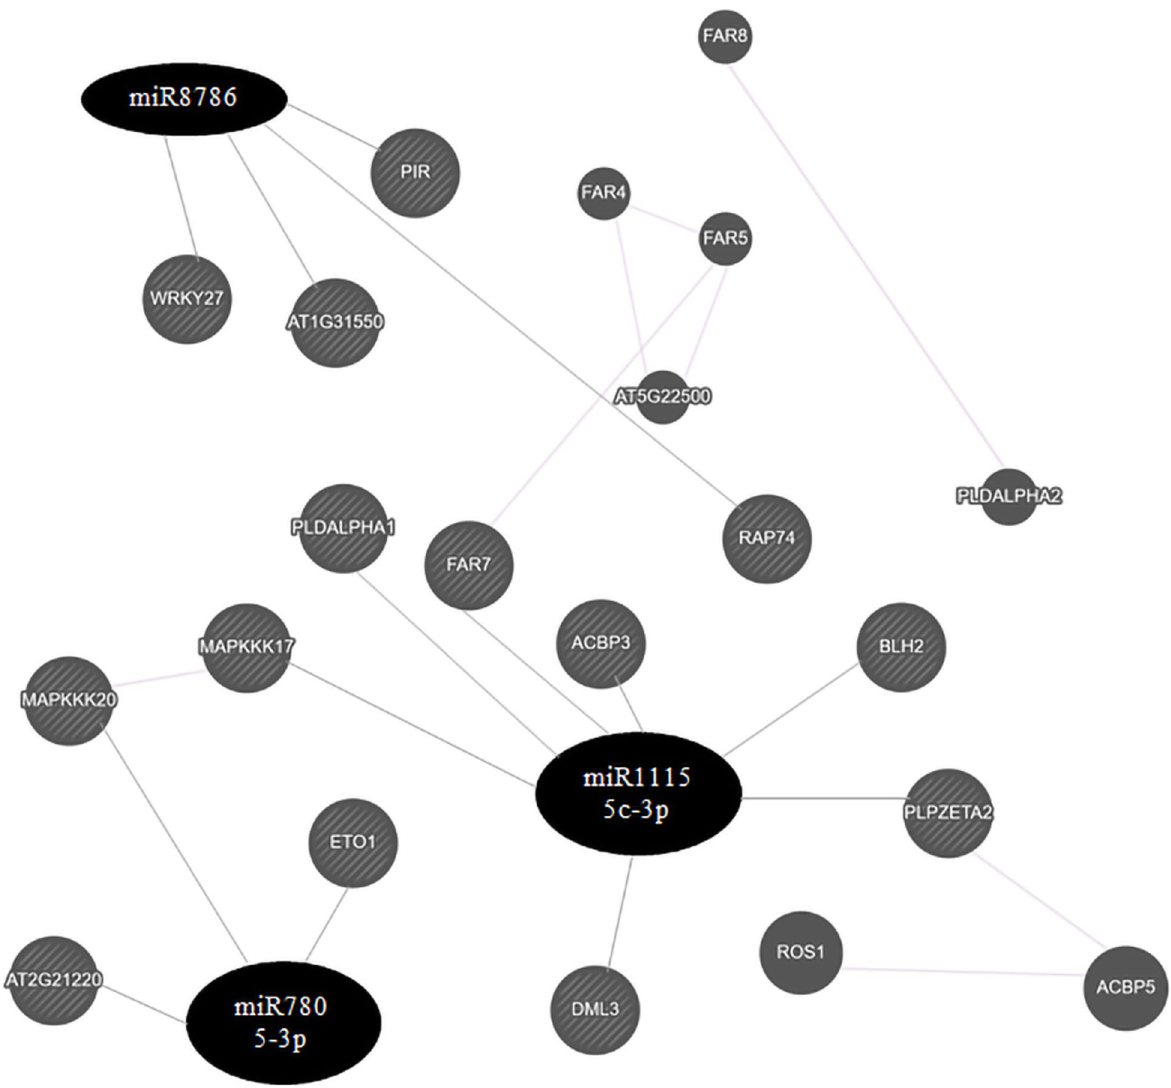
Fig. 5 Co-expression network of potential target genes of the selected